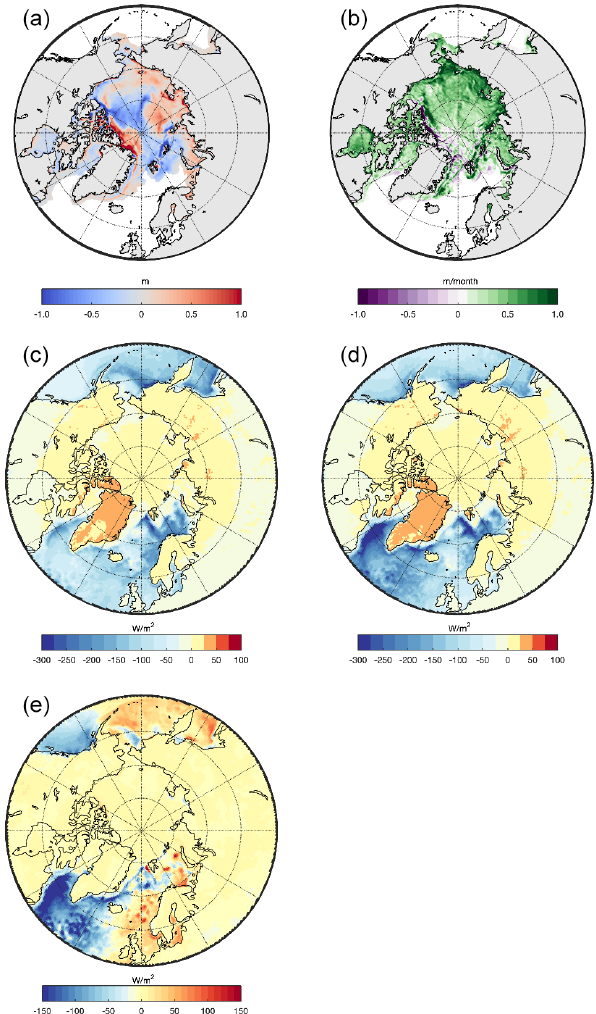
Figure 15. Differences between RASM ensemble members 2 and 8 in accumulated (a) thermodynamic (m/winter) and (b) dynamic sea ice volume tendencies (m/winter) for JFM 2020.